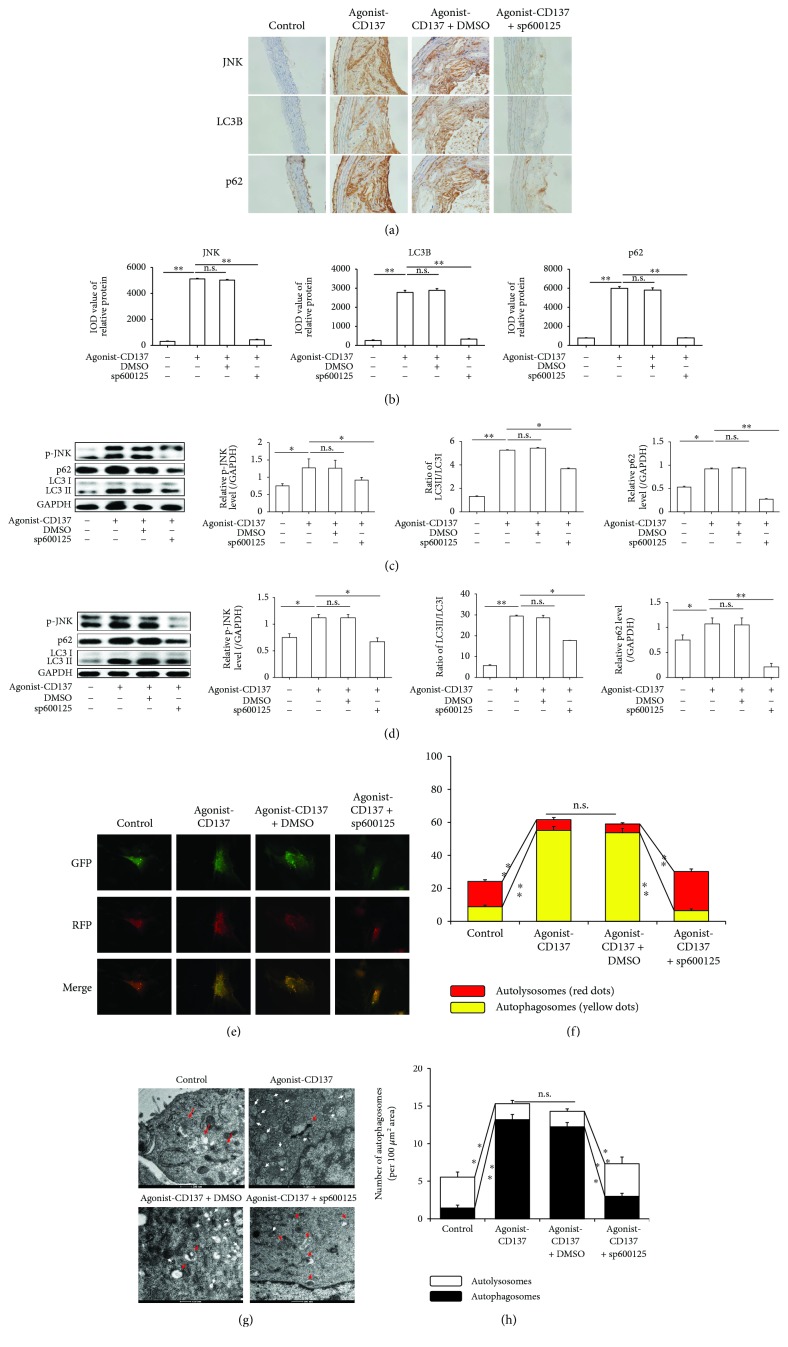
JNK pathway was involved in autophagy dysfunction induced by CD137 signaling. (a–c) The expression of p-JNK, LC3B, and p62 in aortic plaque of ApoE−/− was evaluated by immunohistochemistry staining and Western blot. (d) Western blot was employed for detecting the protein expression of p-JNK, LC3B, and p62 in VSMCs. (e, f) Image showing LC3B staining in each group of VSMCs infected with mRFP-GFP-LC3 adenovirus for 6 h. (g, h) Image showing the number of autophagosomes and autolysosomes in each group of VSMCs detected by transmission electron microscopy (red arrow: autolysosomes; white arrow: autophagosomes). Data are expressed as the mean ± SEM of at least three independent experiments. ∗ refers to P < 0.05; ∗∗ refers to P < 0.01.